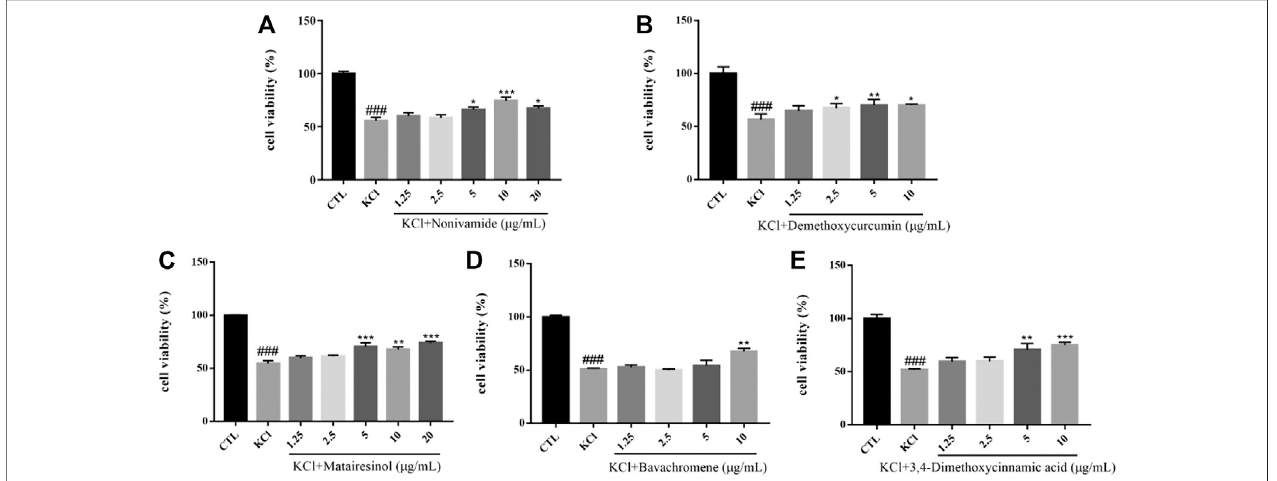
Frontiers in Pharmacology |